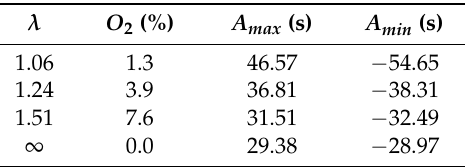
Table 1. The maximum and minimum amplitudes of the four-measurement setup as a function of the air-fuel equivalence ratio [23].